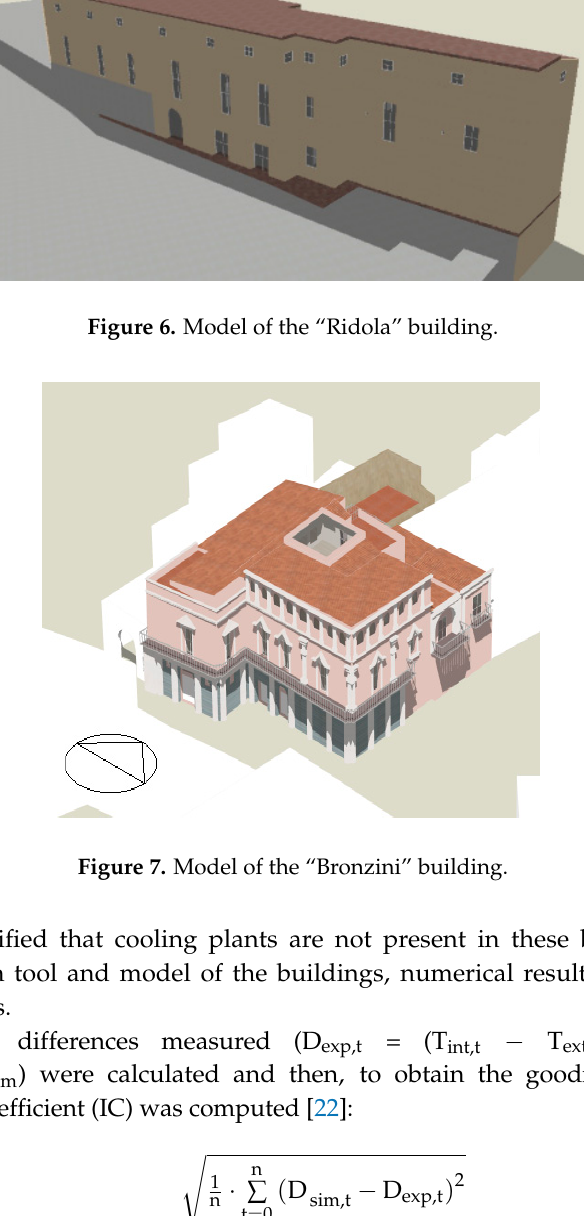
Figure 5. Model of the “Sedile” building.